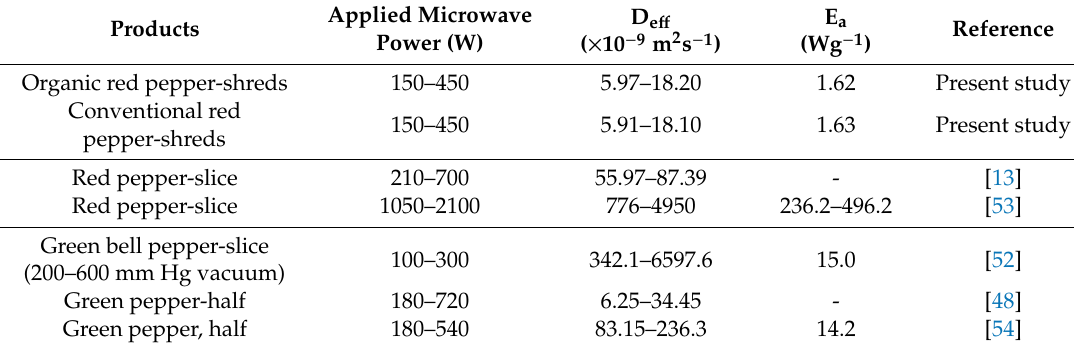
Table 7. E ff ective moisture di ff usivities (D e ff ) and activation energies (E a ) of peppers dried by intermittent microwave as compared to the values in previous studies.